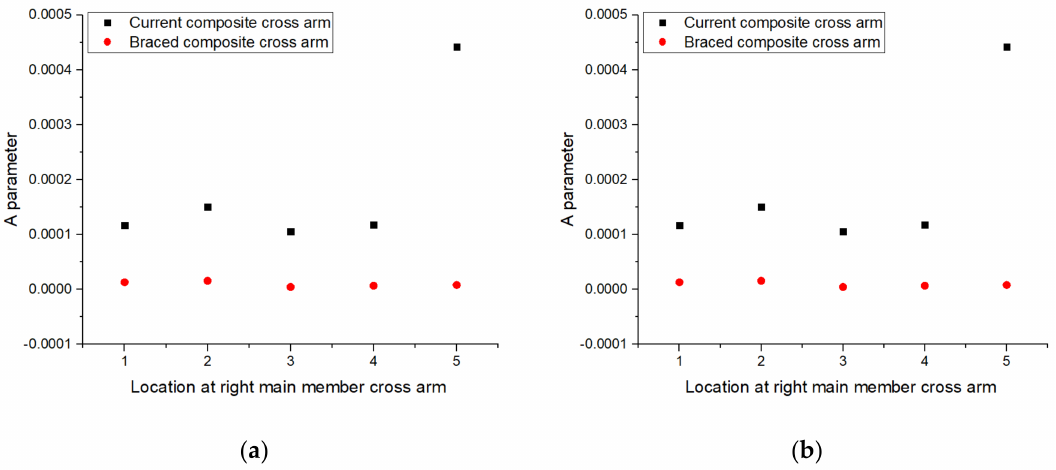
Figure 9. A parameter for current and braced PGFRPC cross-arms: ( a ) right; ( b ) left main